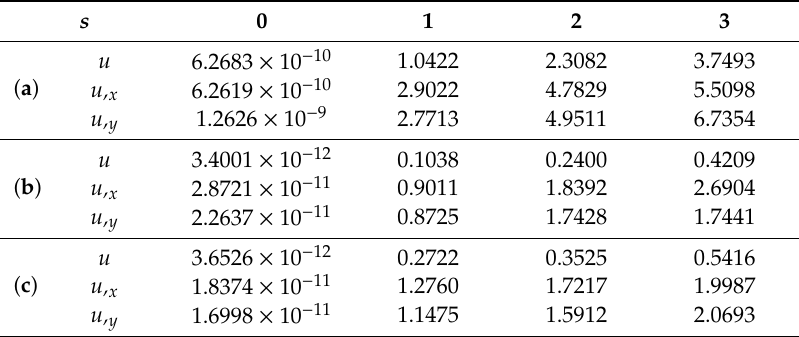
Figure 9. Comparison of numerical solutions along missing boundary obtained by various s on the boundary conditions: ( a ) half unknown outer boundary; ( b ) half unknown inner boundary; ( c ) unknown inner boundary. Table 1. Comparison of maximal absolute errors (%) obtained by various s : (a) half unknown outer boundary; (b) half unknown inner boundary; (c) unknown inner boundary.